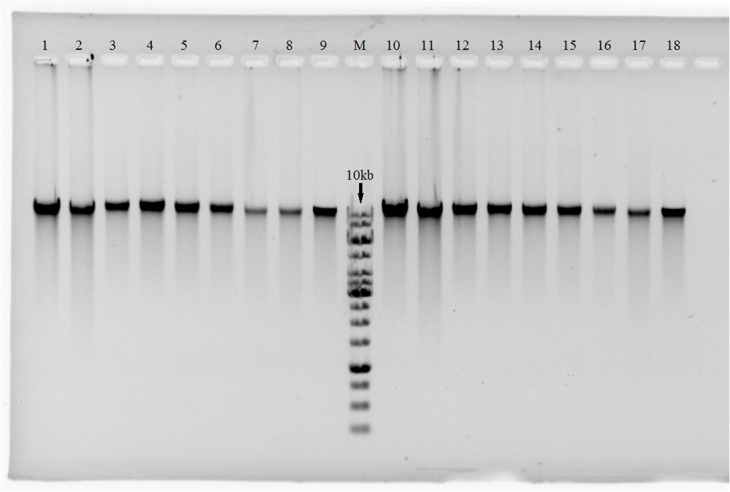
Gel electrophoretic result of extracted DNA indicating similar DNA integrity between bead-beating (right of lane M) and non-bead-beating (left of lane M) methods.Lanes 1, 10: A. fundyense; 2,11: K. mikimotoi; 3, 12: P. donghaiense; 4,13: S. costatum; 5,14: C. muelleri; 6,15: T. weissflogii; 7,16: I. galbana; 8,17: Chlorella sp.; 9,18: H. akashiwo. M is GeneRuler 1kb DNA Ladder (Thermo Scientific, USA) with the largest size of 10 kb.